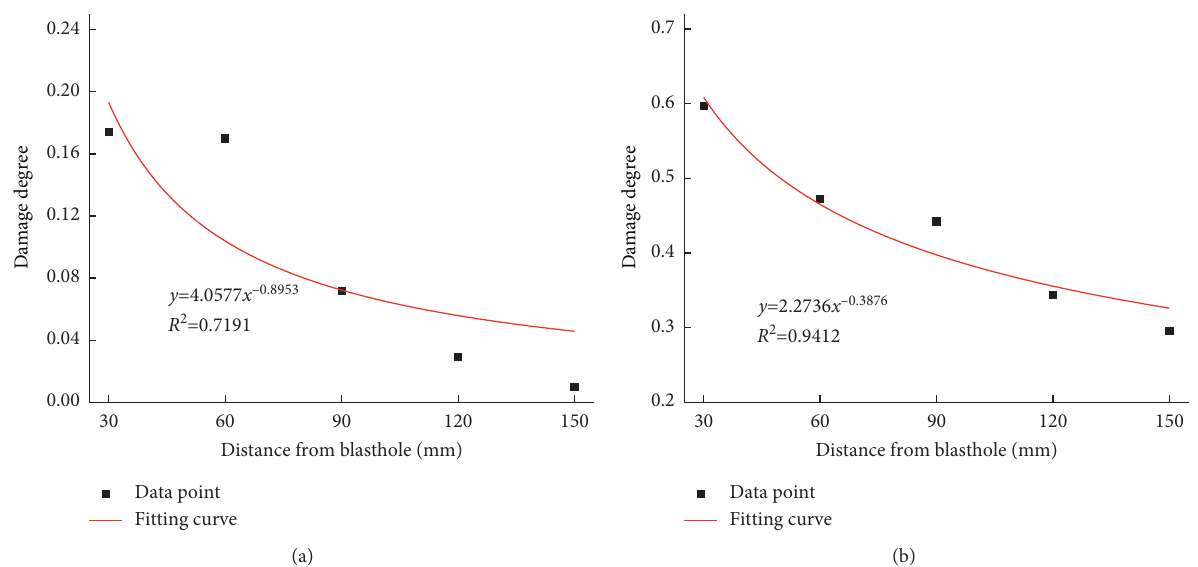
Figure 7: The fitting curve of damage degree and distance of specimen. (a) Vertical cutting direction. (b) Slitting